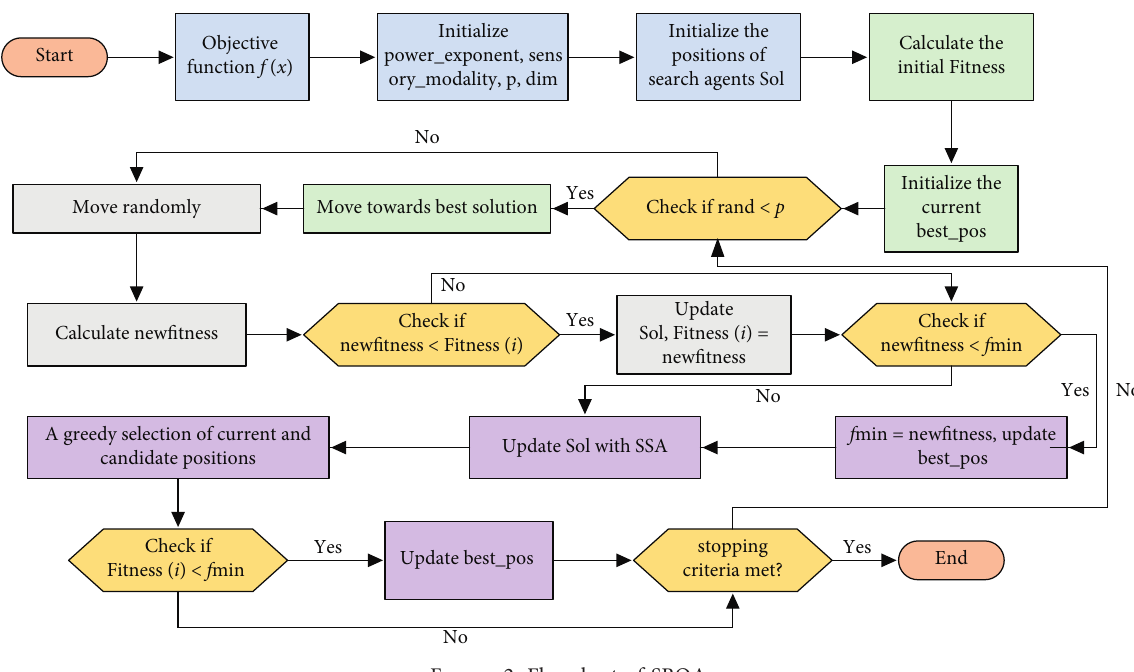
Figure 2: Flowchart of SBOA. Table 3: Parameters of the involved